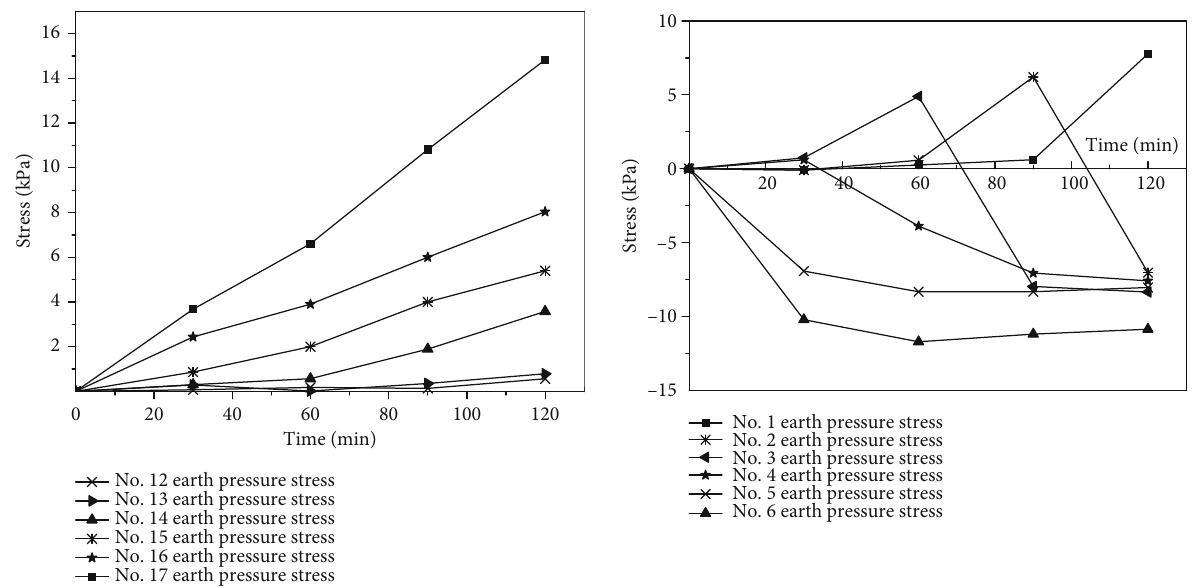
Figure 10: Evolution of soil pressure along